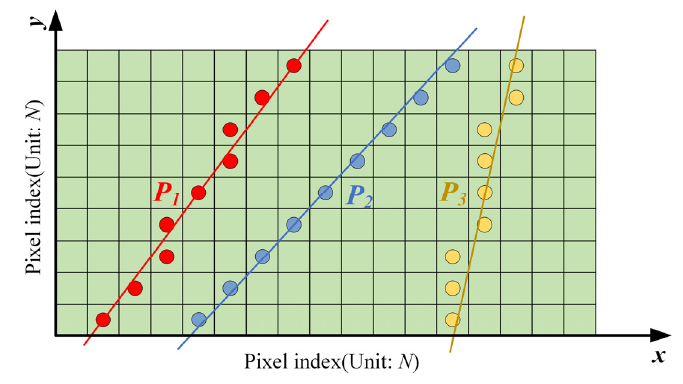
Figure 5. Principle of phase similarity.